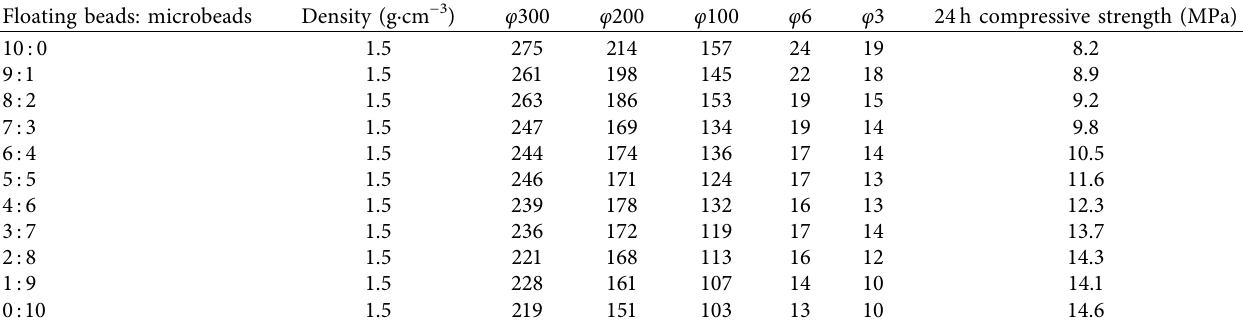
Table 2: Effect of the ratio of mixing floating beads on the cement slurry.